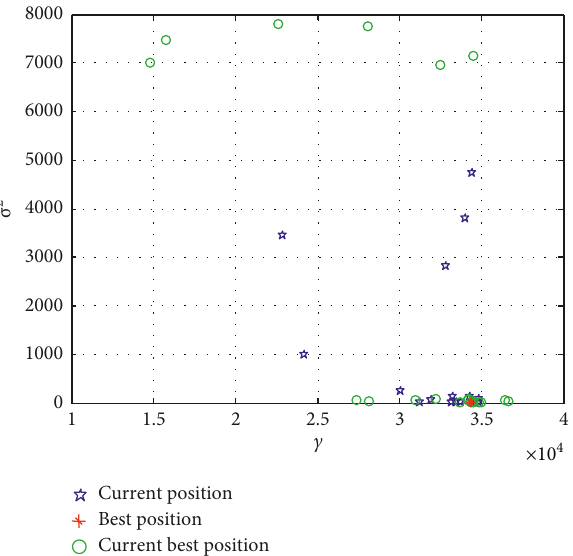
Figure 4: Particle distribution at final